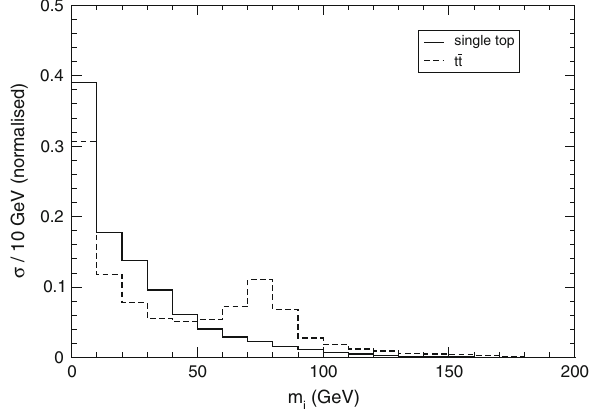
Fig. 3 Normalised distributions of the light jet mass for the single top signals and the t ¯ t background, in the 1 b sample with the baseline selection